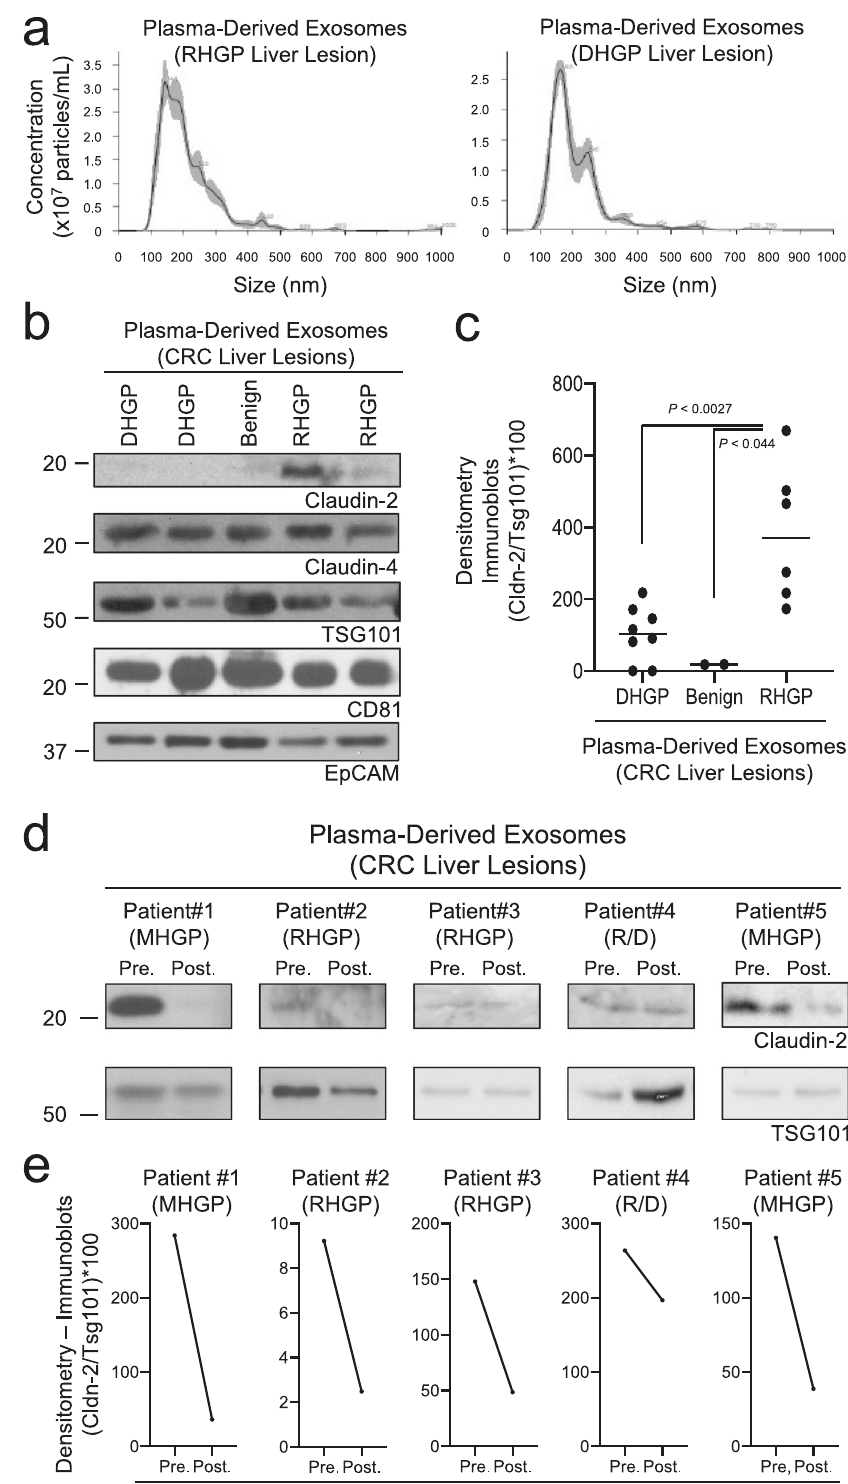
Fig. 6 Claudin-2 is enriched in extracellular vesicles isolated from patients with replacement-type colorectal cancer liver metastases. a Nanoparticle tracking analysis of EVs detected in plasma derived from either a RHGP liver lesion bearing patient or a DHGP liver lesion bearing patient. b Representative immunoblot analysis of Claudin-2, Claudin-4, CD81, EpCAM, and TSG101 using lysates prepared from EVs isolated from patients with the indicated lesions. c Claudin-2 levels in EVs concentrated from plasma of liver-metastatic CRC patients with the indicated lesions were normalized to TSG101 levels. d Immunoblot analysis of Claudin-2 and TSG101 using lysates prepared from EVs concentrated from patients, pre- and post-resection, with the indicated lesions. e Claudin-2 levels in EVs concentrated from plasma, pre- and post-resection, of liver-metastatic CRC patients with the indicated lesions were normalized to TSG101